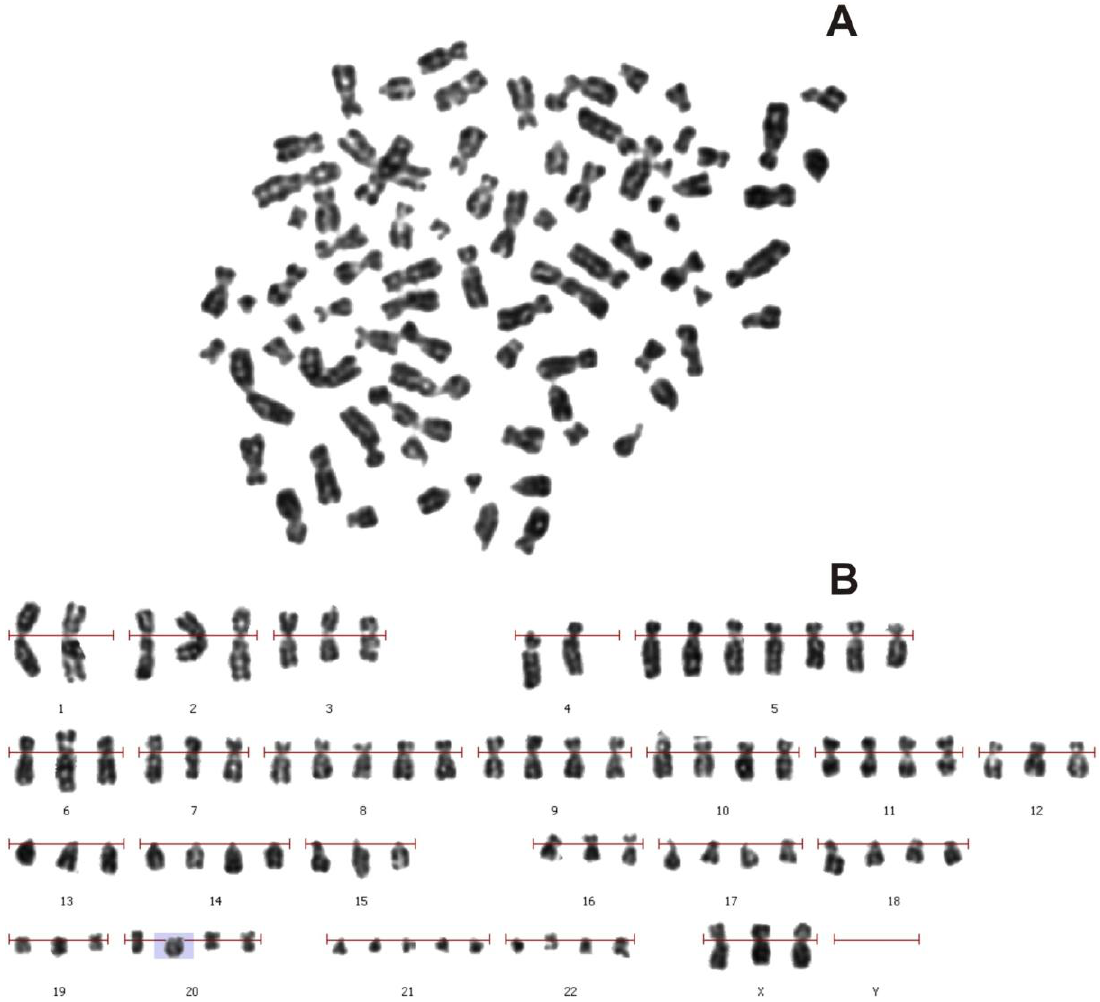
FIGURE 8. Multiple polysomy induced by ultramicroforms in lymphocytes of human peripheral blood. (A) Metaphase plate; (B)